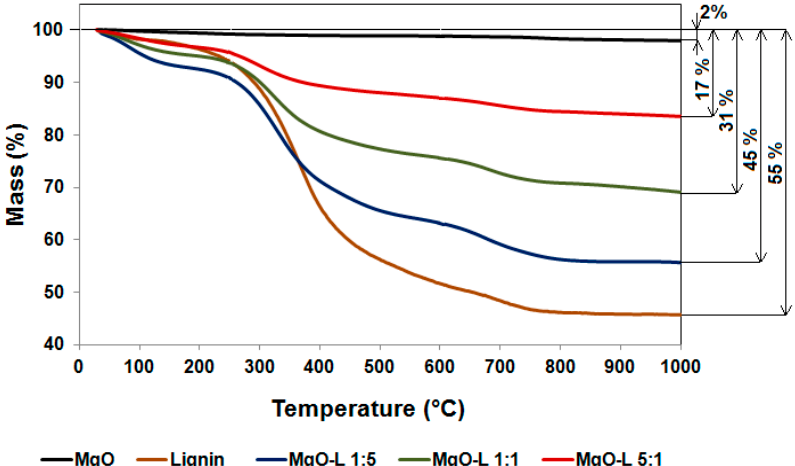
Figure 2. Thermogravimetric analysis (TGA) curves of pristine components (MgO and lignin) and inorganic–organic hybrid materials.